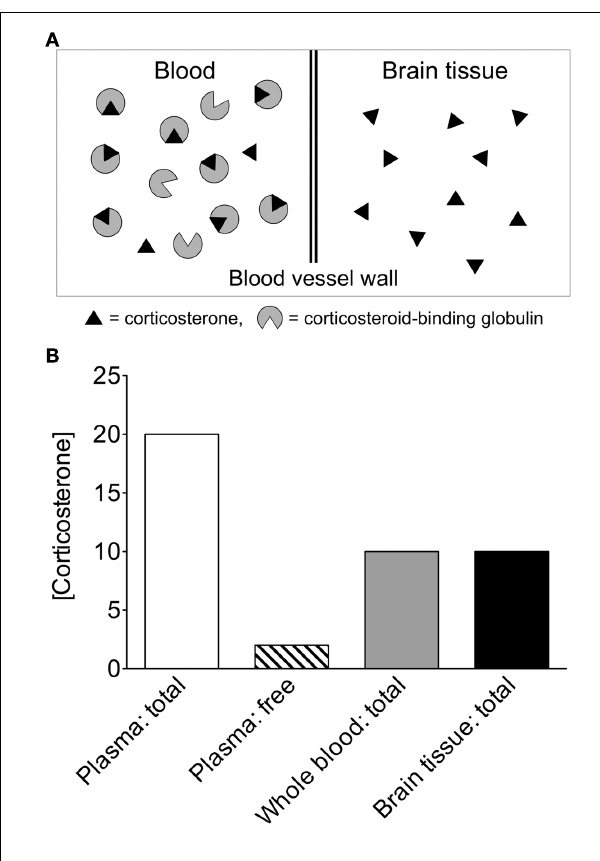
FIGURE 4 |Theoretical comparison of circulating and tissue steroid concentrations. (A) If the same amounts of steroid are present in equal volumes of blood and brain, different interpretations can be made, depending on how steroids are quantified in blood. In the circulation, the vast majority of corticosterone is bound to corticosteroid-binding globulin (CBG; Hammond, 1990). CBG-bound steroids have very limited access to tissue and limited ability to cross the blood–brain barrier. (B) Corticosterone concentrations in whole blood are approximately 50% of those in plasma (Taves et al., 2010), and within plasma, the vast majority of corticosterone is bound to CBG. In the above theoretical scenario, if whole blood corticosterone is measured, then circulating levels appear identical to tissue levels. If plasma total corticosterone is measured, then circulating levels appear much higher than tissue levels. If plasma free corticosterone is measured, then circulating levels appear much lower than tissue levels. Thus, the use of whole blood steroid measurements or plasma free steroid measurements is highly informative in addition to plasma total steroid